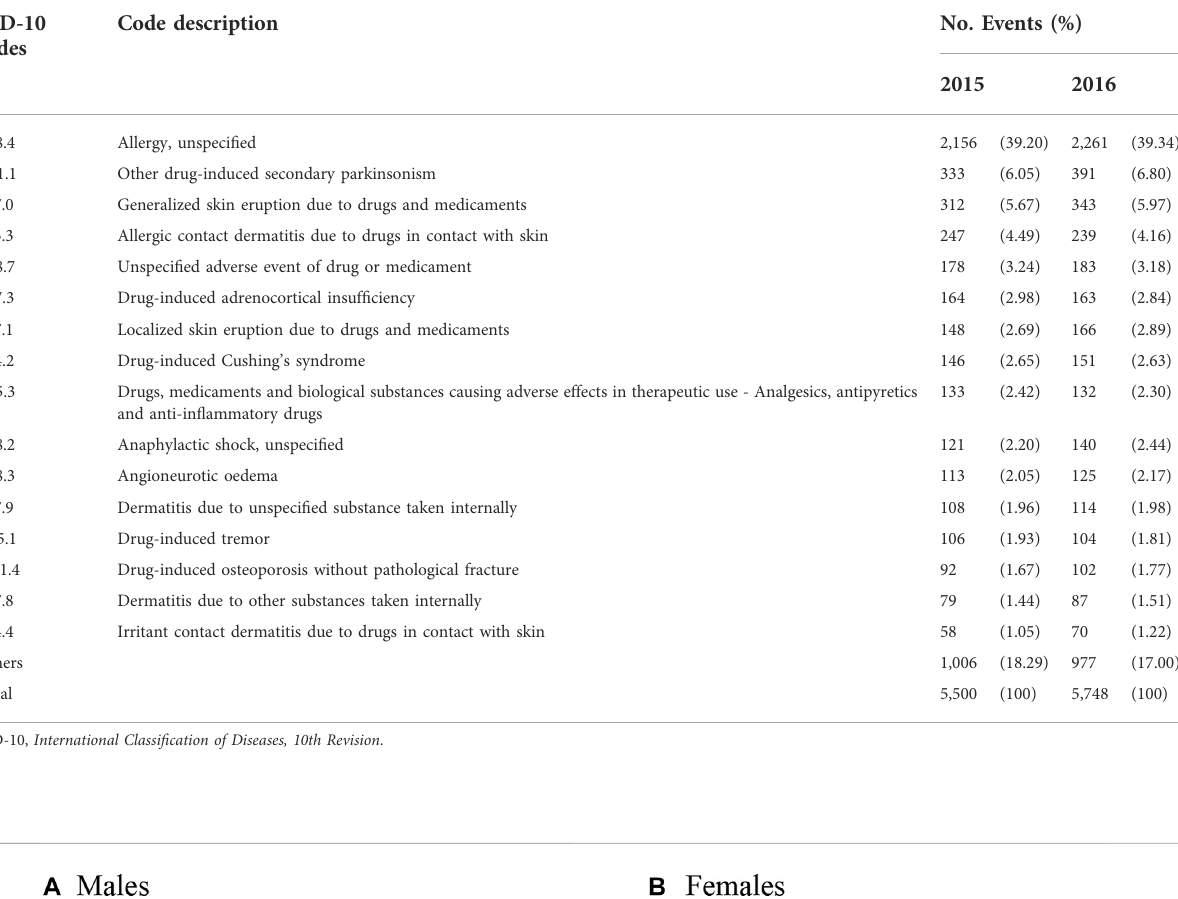
TABLE 3 Most frequent type of adverse drug events in 2015 – 2016.